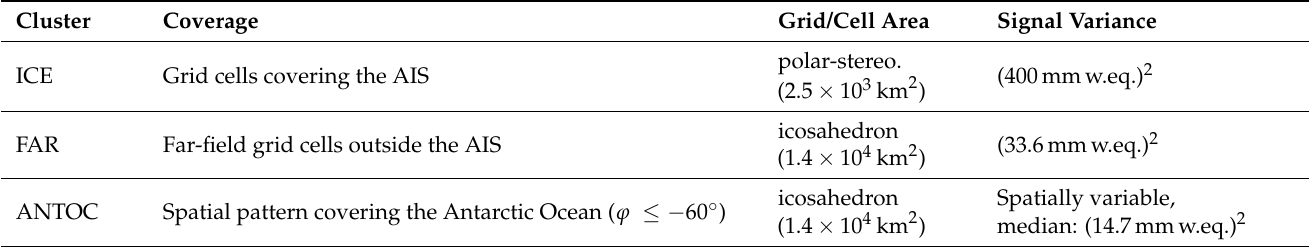
polar-stereo. (400mmw.eq.) 2 (2.5 × 10 3 km 2 ) icosahedron (33.6mmw.eq.) 2 icosahedron Spatially variable, (1.4 × 10 4 km 2 ) median: (14.7mmw.eq.)